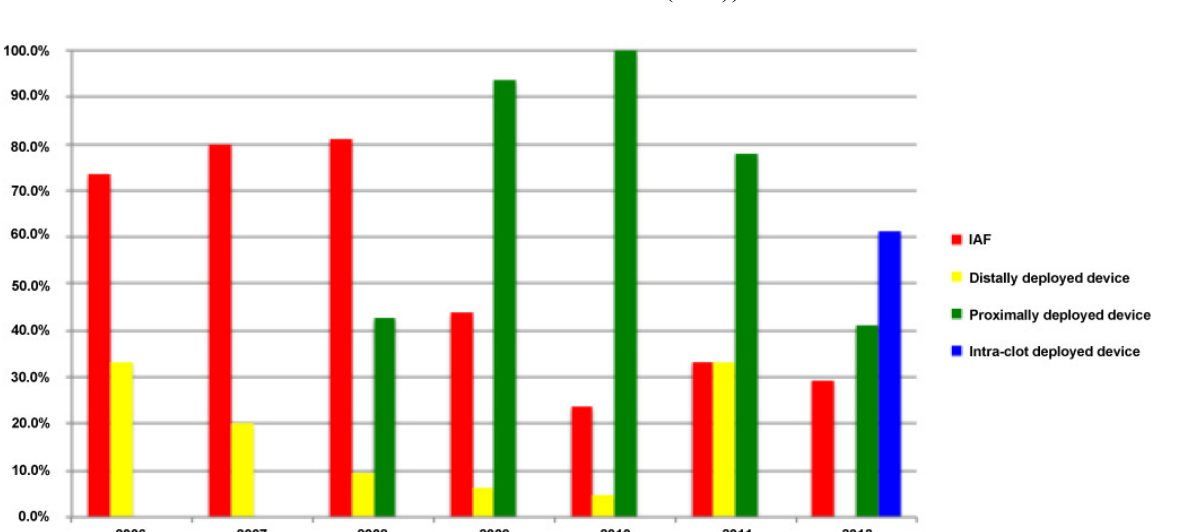
Figure 4. Endovascular treatment modalities used by year (as a percentage of all endovascular interventions for acute ischemic stroke